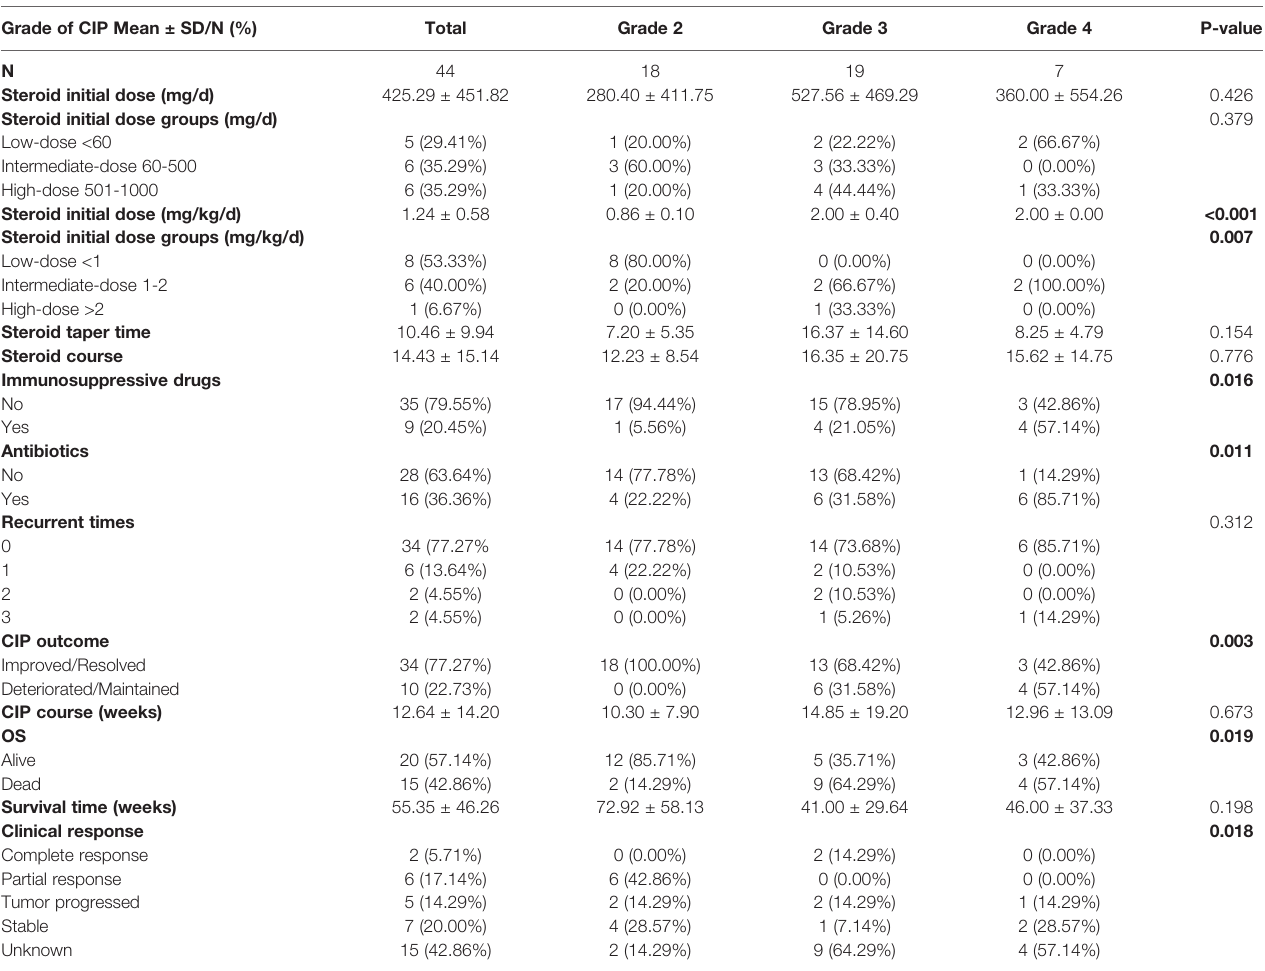
TABLE 3 | The characteristics related to management of CIP strati fi ed by grade of CIP. Grade of CIP Mean ± SD/N